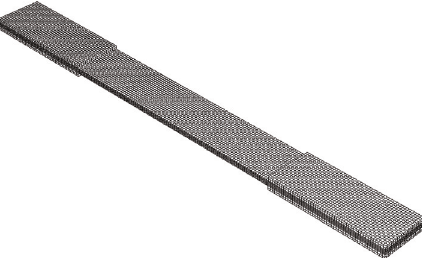
Figure 16: Finite element mesh used in the tensile test simulation.